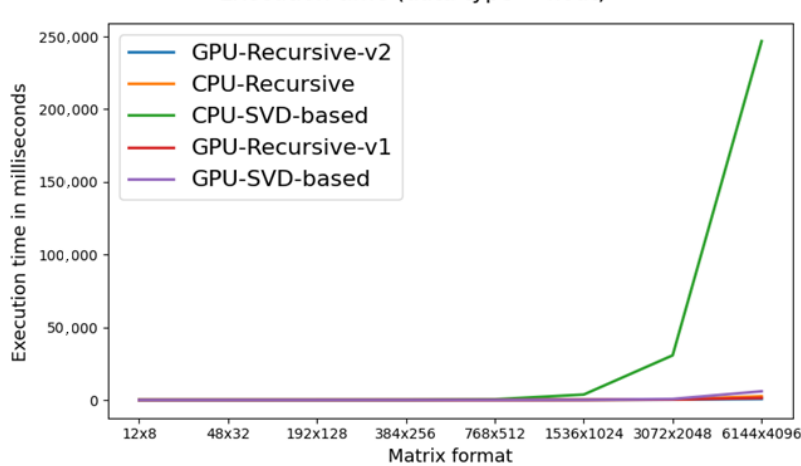
Algorithms 2022 , 15 , x FOR PEER REVIEW 13 of 18